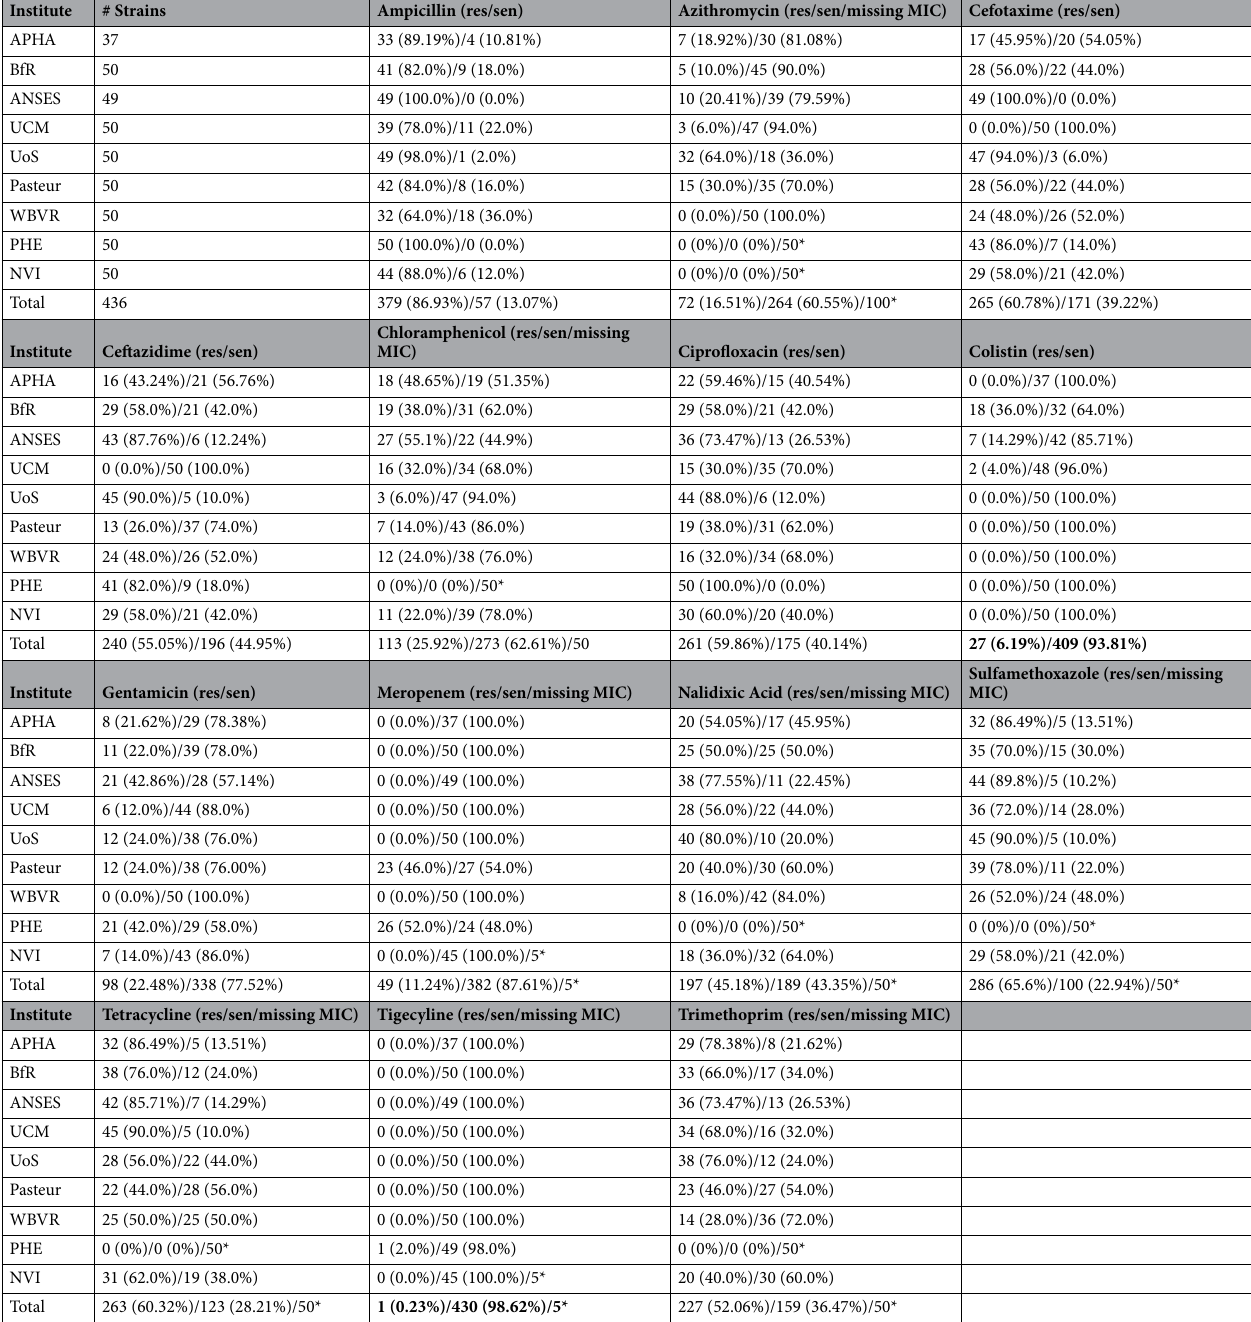
Table 2. Number of resistant and susceptible isolates per antimicrobial used in this study. The numbers, including percentage, of resistant and susceptible isolates provided by the nine collaborating institutes for each of the 14 antimicrobials are given. Antimicrobials for which the MIC data was not available for all, or part of the isolates provided by an Institute have been marked (*). Cells in bold indicate unbalanced ratio with resistant isolates being less than 10% of